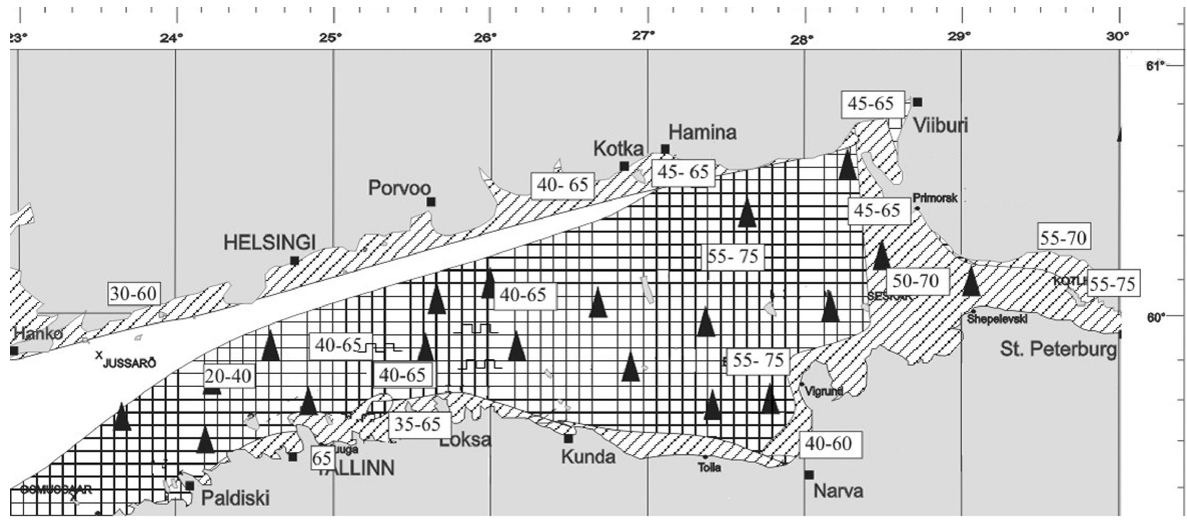
Fig. 6. Ice chart of the typical severe winter (1 April) in the ice season 2002/03. In the previous few days the strongest winds blew from the N to NW sector. The diagonal lines indicate fast ice and squares consolidated ice, is ridging ice and rafting. The ice chart (in Estonian) was provided by the Estonian Meteorological and Hydrological Institute.